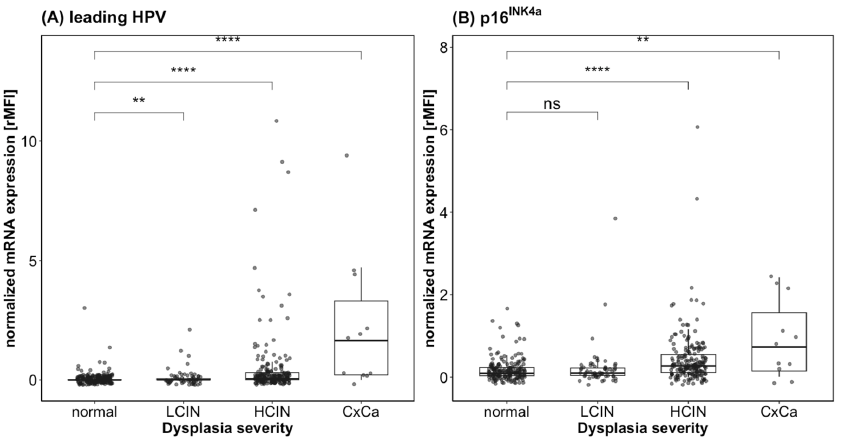
Figure 3. Biomarker ‐ expression strength detected by QG ‐ POC assay. mRNA expression of E7 of the leading HPV genotype ( A ) and p16 INK4a ( B ) for the clinical stages as classified for their severity by the ASSIST score. The relative expression of HPV ‐ E7 (for the leading HPV type) and for p16 INK4a is shown as box whisker plots and dot plots for individual samples (gray dots) by the different dysplasia score categories. The MFI values are normalized to the reference marker ACTB resulting in relative MFI (rMFI). The p -values of the Wilcoxon test are shown for the group comparisons: ns, not significant, ** p < 0.01, **** p <